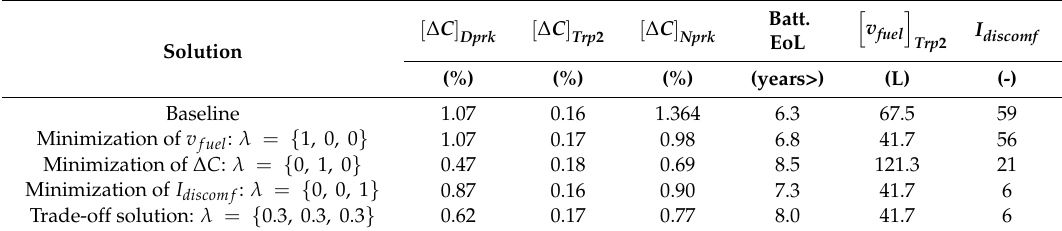
Table 7. Breakdown of cost terms for different solutions of Equation (13). The capacity loss and the fuel consumption figures are quoted per